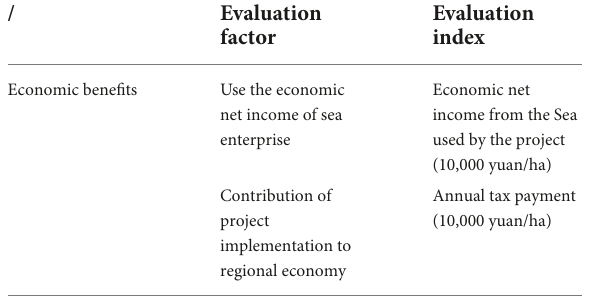
TABLE 8 Ecological benefit evaluation elements and evaluation indexes.